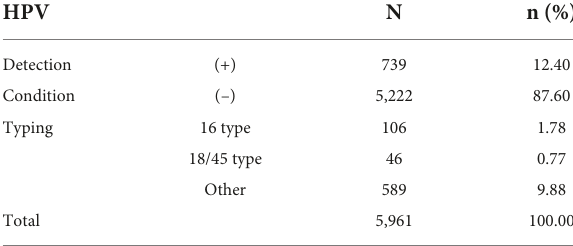
TABLE 8 Human papillomavirus (HPV) screening results in cervical